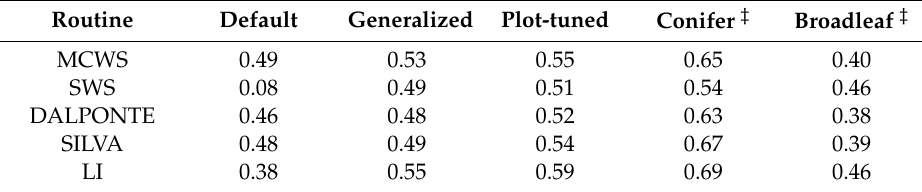
The table included default, generalized, and plot-tuned parameters. ‡ Conifer and broadleaf accuracies are from plot-tuned model